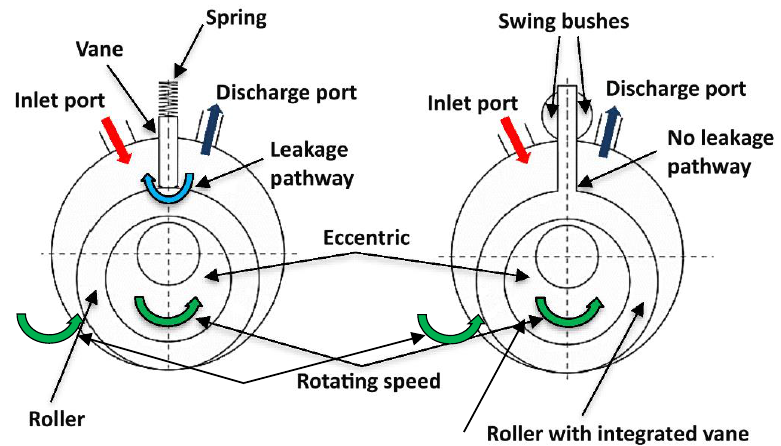
Figure 16. Principle of operation of a rolling ( left ) and swing ( right ) piston expander.